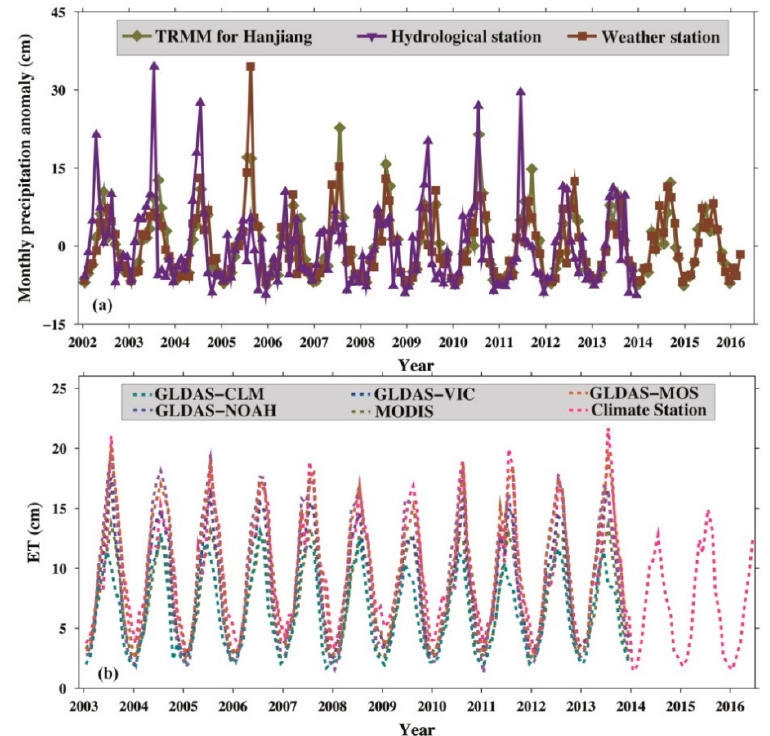
Figure 6. ( a ) Change in precipitation in the DJKR from the Tropical Rainfall Measuring Mission (TRMM), hydrological station, and weather station; ( b ) evapotranspiration (ET) in the DJKR from the four GLDAS models, Moderate Resolution Imaging Spectroradiometer (MODIS), and weather station. The TWSA from GRACE and CLM4.0 data, water-level change from in situ data, and